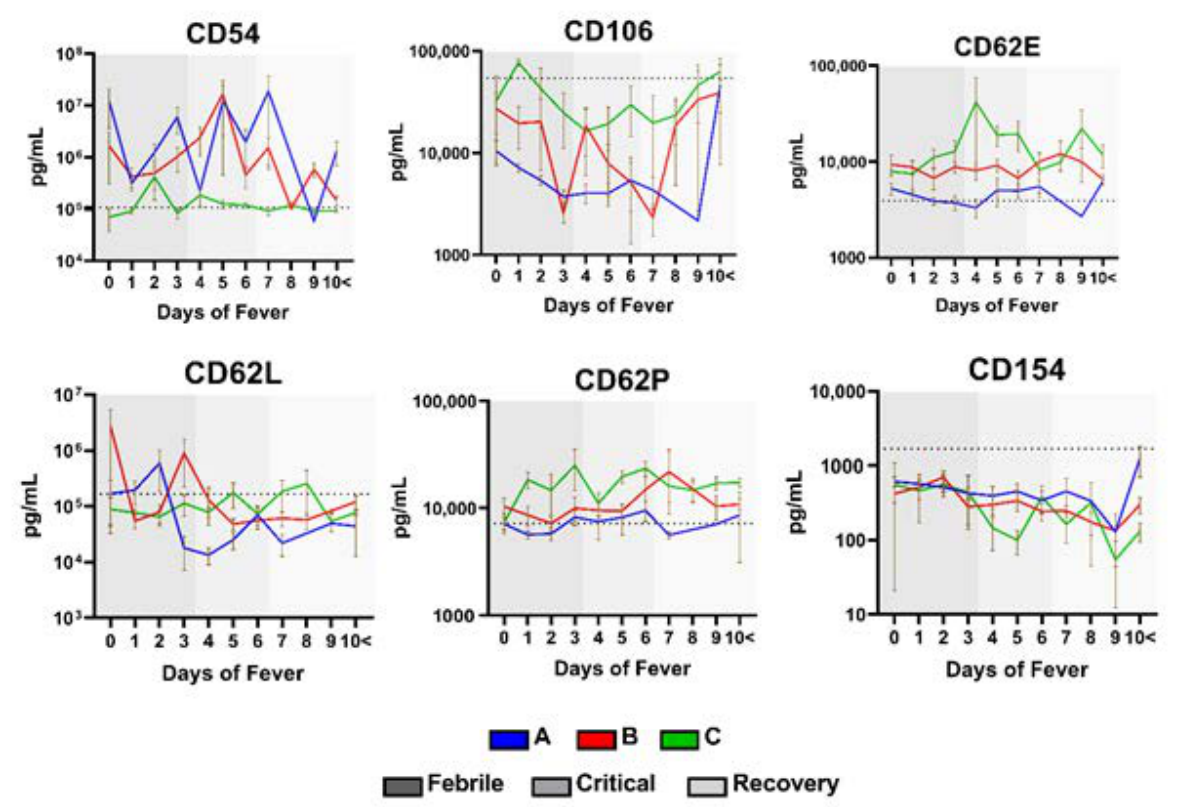
Figure 3. The level of Adhesion molecules in dengue patients at different days of fever. Graphs representing the levels between the different groups of DENV patients previously divided following the 2009 WHO dengue classification scheme: dengue without warning sign symptoms (A), dengue with warning signs (B) and severe dengue (C). Colored shadings represent the different phases of dengue fever. Horizontal dotted line represents healthy mean average. Mean ±